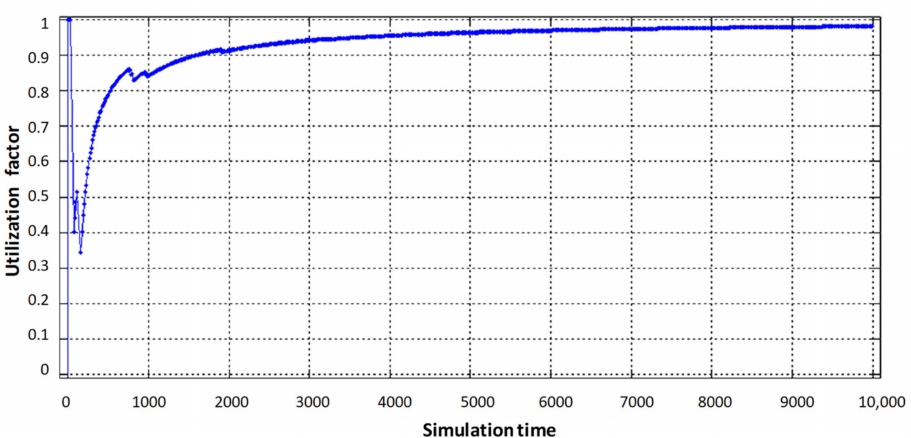
Figure 7. Service device loading of the virtual router with flows: ( a ) video, ( b ) voice, ( c ) data.